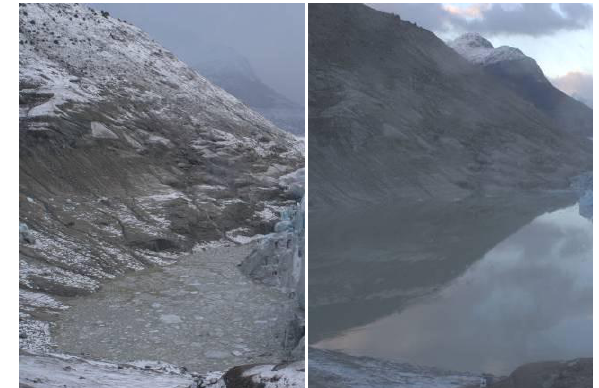
Figure 10. Two images of a sequence taken on Lago Nef Norte showing the same area under different conditions. Effects in the images (reflections, ice and snow on the water etc.) hamper the automatic water line